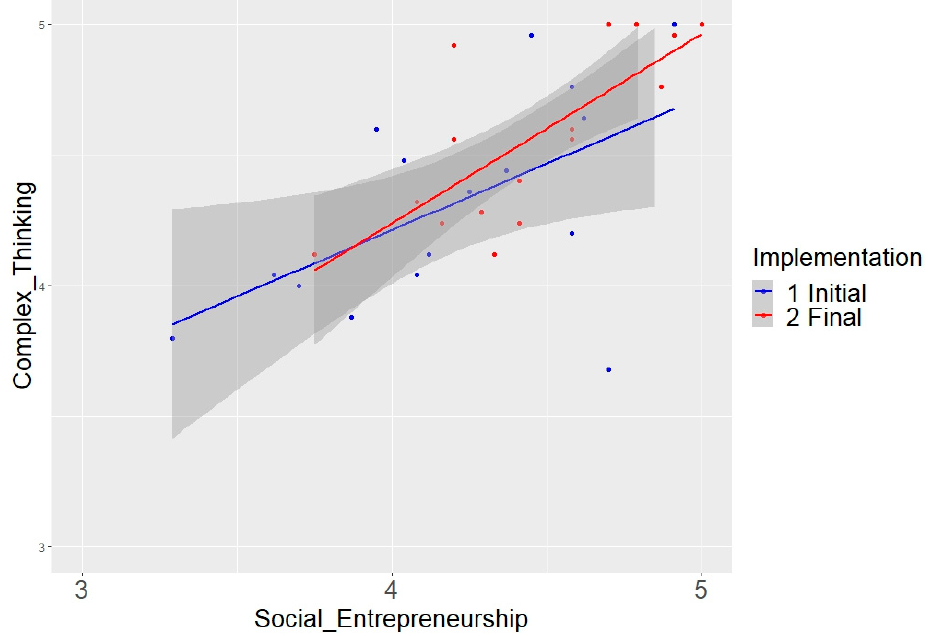
Figure 3. Results showing the positive correlation between social entrepreneurship and complex thinking competencies (Initial–Final).